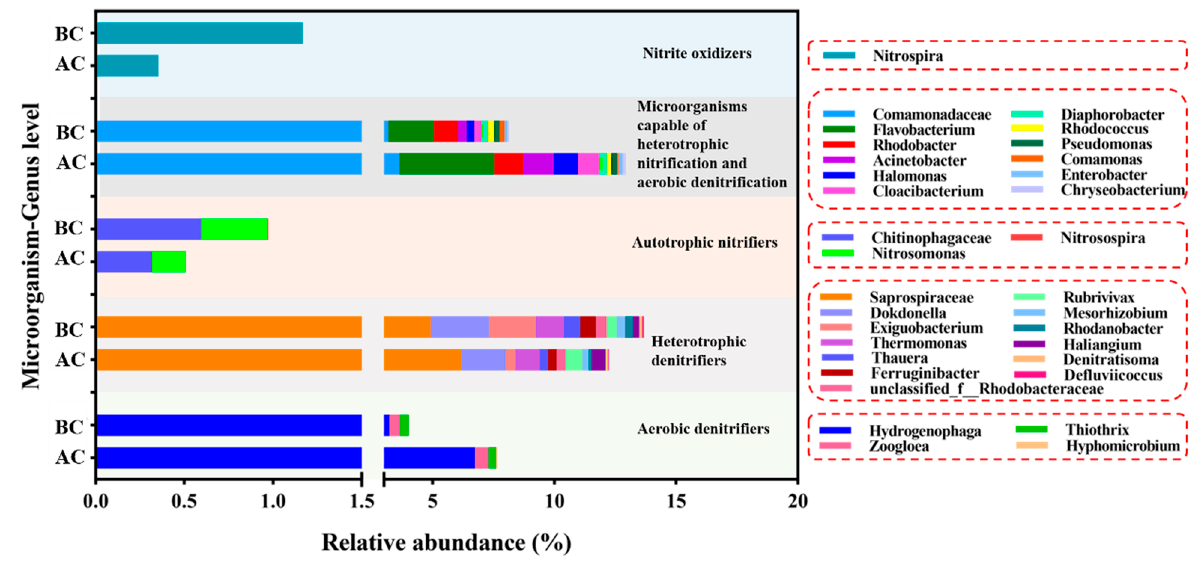
Figure 7. Relative abundance of nitrogen removal functional bacterial communities at genus level of biofilm before cleaning (BC) and after cleaning (AC).